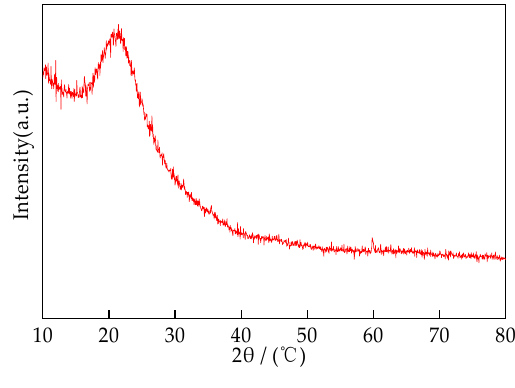
Figure 3. XRD diagram of silica fume.